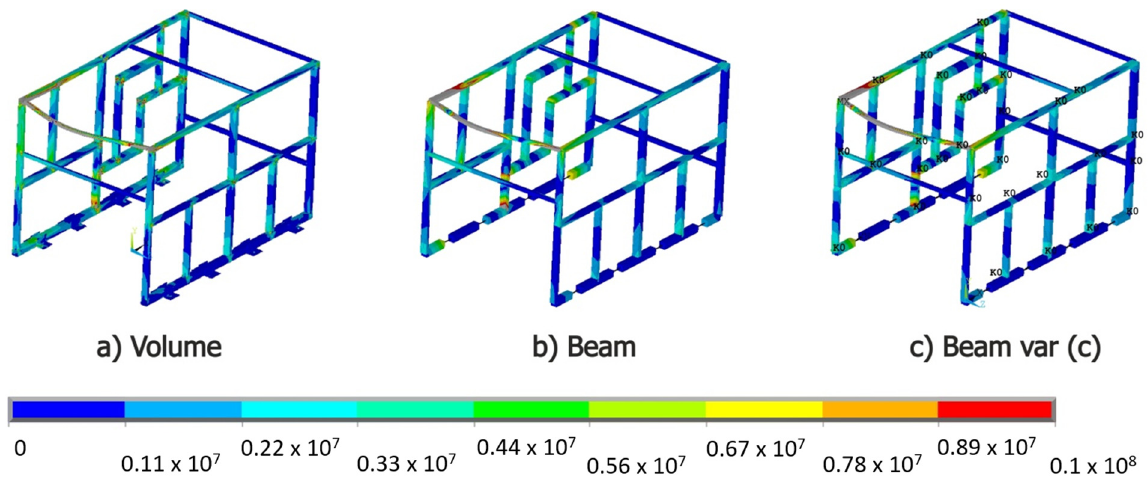
Figure 16. Von Mises stress maps for the validation structure modeled with volume, beam, and alternative beam type elements [MPa].